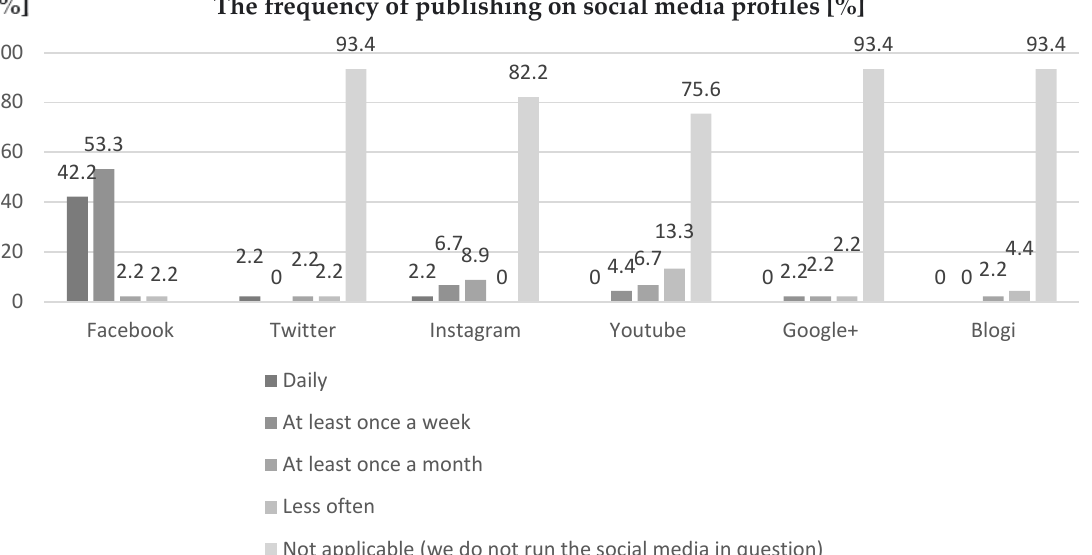
Figure 6. Frequency of publishing material on social media profiles. Source: authors ’ own elabora- tion.